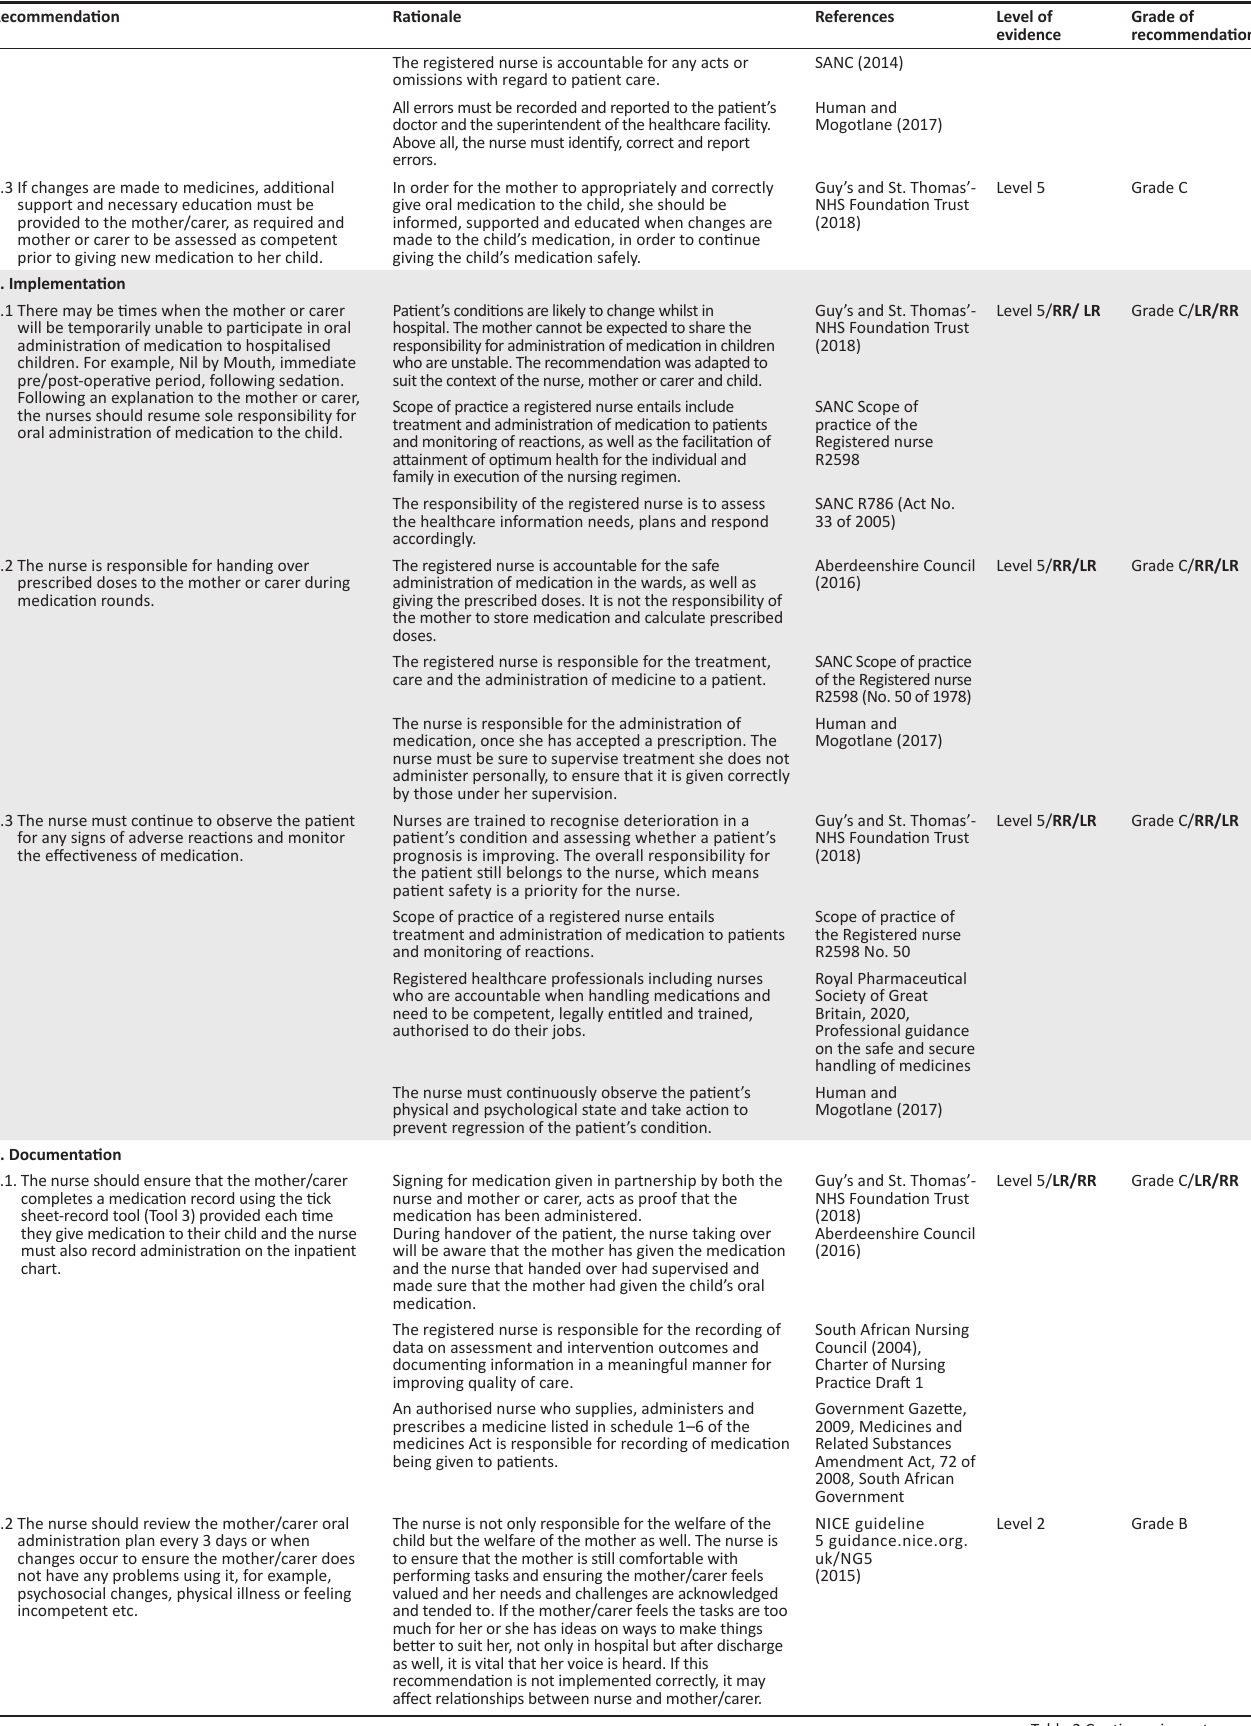
TABLE 2 (Continues...): Recommendations with level of evidence and grade of